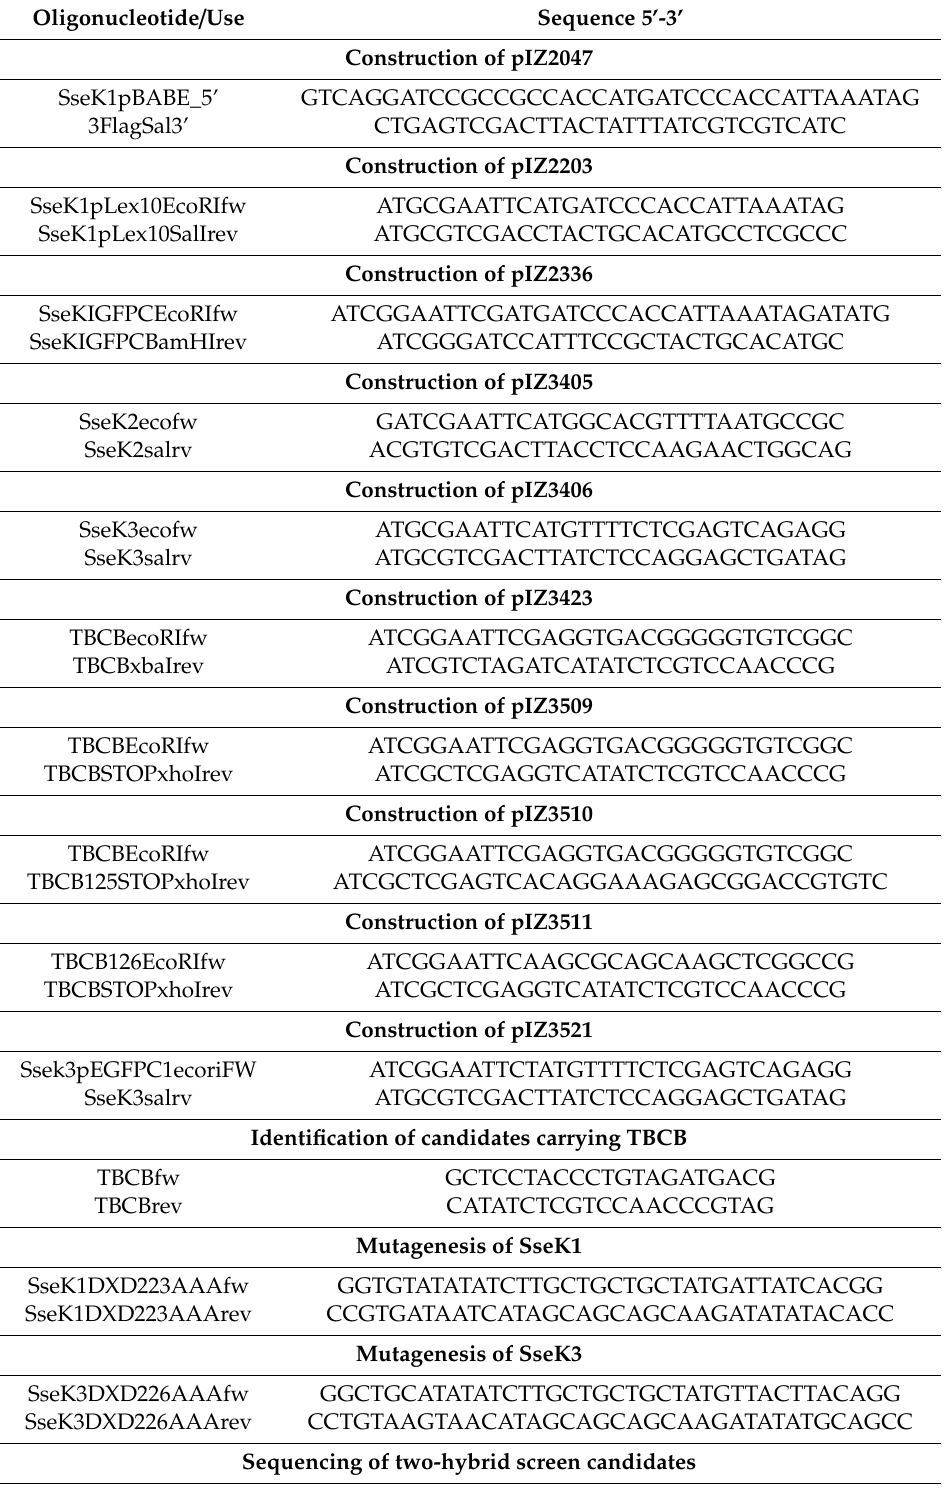
Table 3. Oligonucleotides used in this